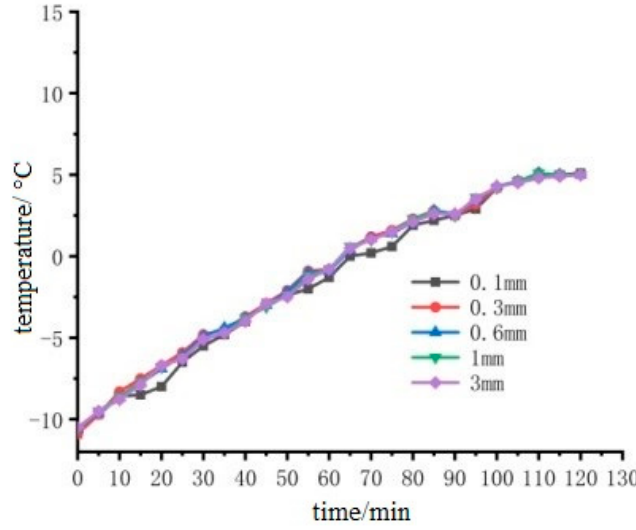
Figure 16. Heating diagram of electrodes of different thicknesses heated for two hours.